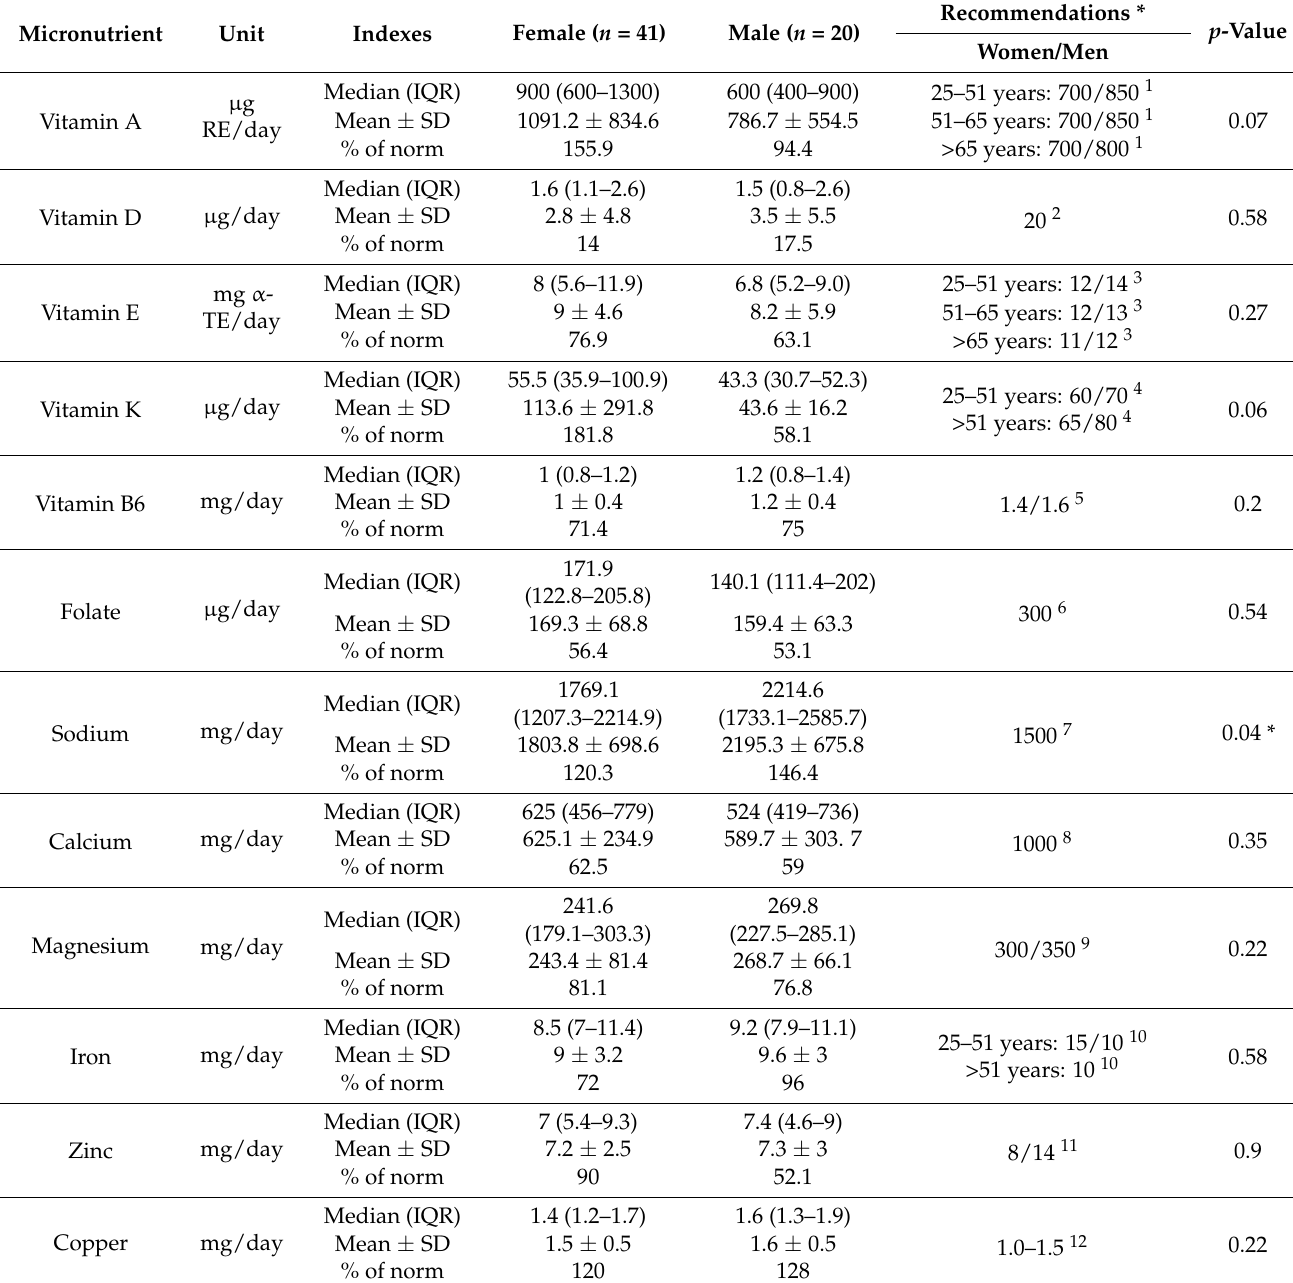
Table 5. Selected micronutrient intake in patients with RA ( n =